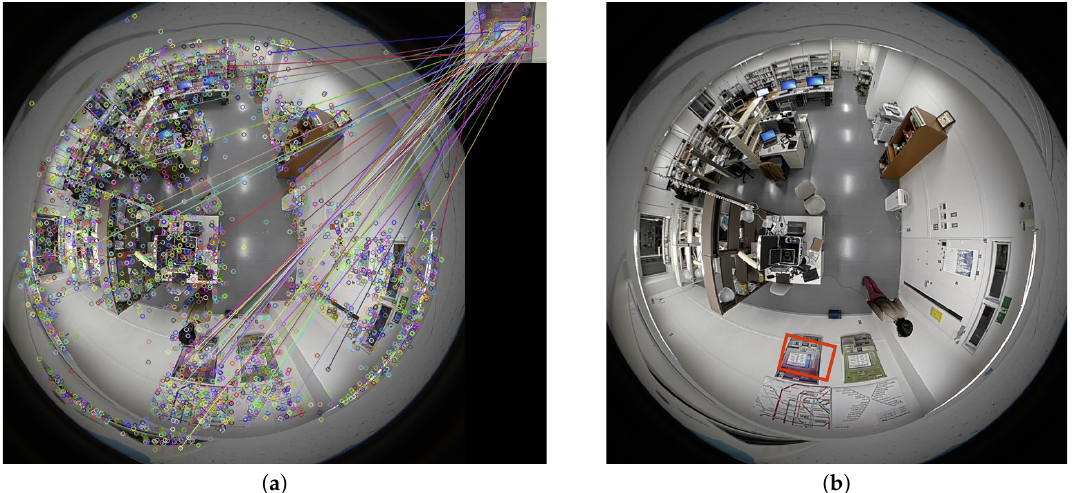
Figure 2. First stage of image matching. ( a ) feature point matching. The large image is the fisheye image, and the small image at the upper-right corner is the eye-tracker image. ( b ) roughly detected region. This region that corresponds to the eye-tracker image is indicated as a red rectangle in the fisheye